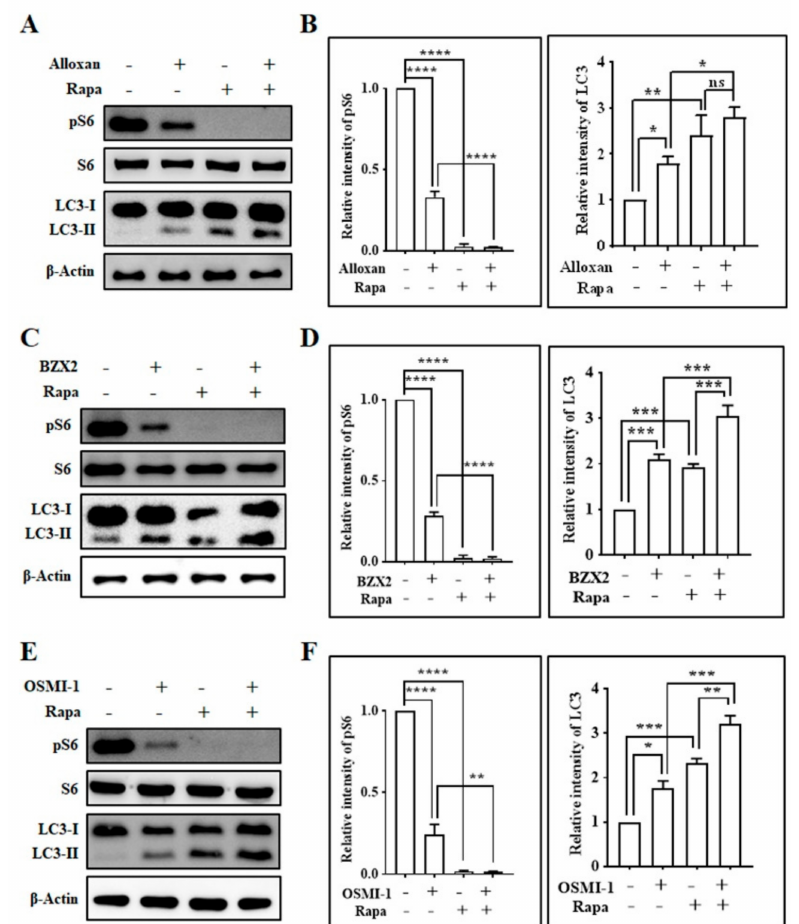
Figure 2. Inhibition of OGT regulates mTOR signaling pathway in rat cortical neurons. ( A , C , E ) Neurons were pretreated with rapamycin (100 nM) for 30 min before in the absence / presence of alloxan (5 mM), BZX2 (100 µ M), and OSMI-1 (50 µ M) for 24 h. Cells were harvested and pS6, S6, and LC3 expression levels were examined by immunoblot analysis. ( B , D , F ) Densitometry analysis of pS6 and LC3 protein levels quantified by Image J. All data are presented as mean ± SEM ( n = 3, ns; non-significant, * p < 0.05, ** p < 0.01, *** p < 0.001, **** p <